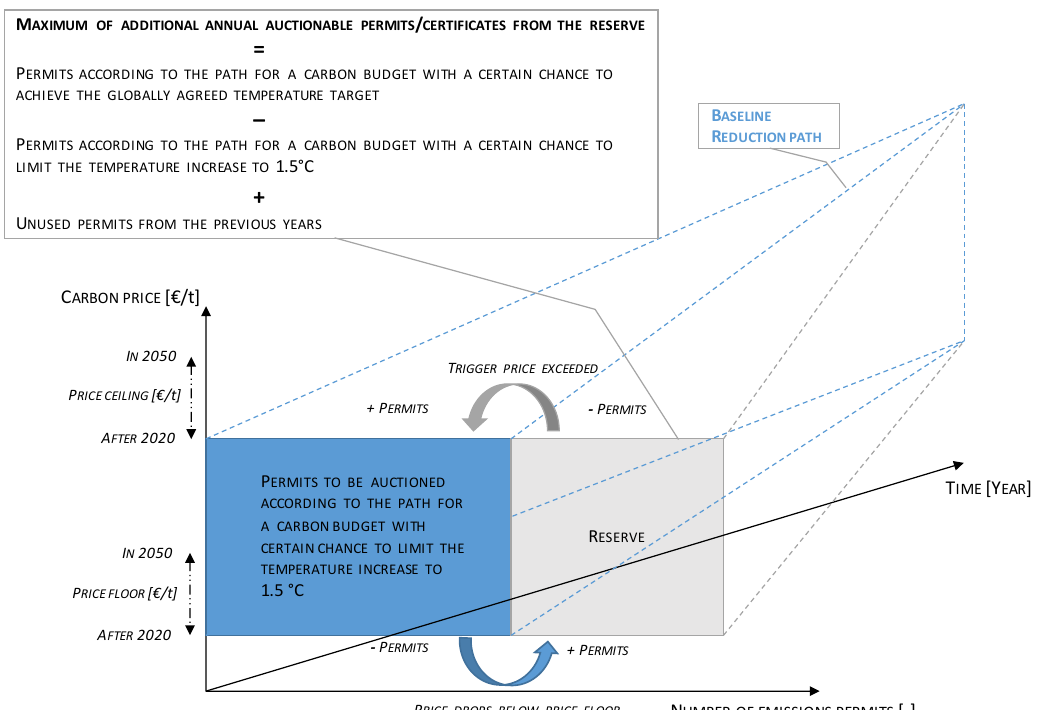
Figure 5. Proposal of a hybrid cap-and-trade system.